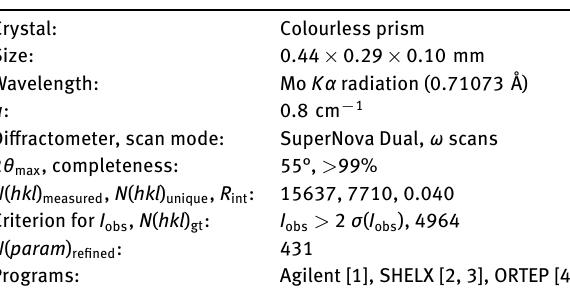
Table 1: Data collection and